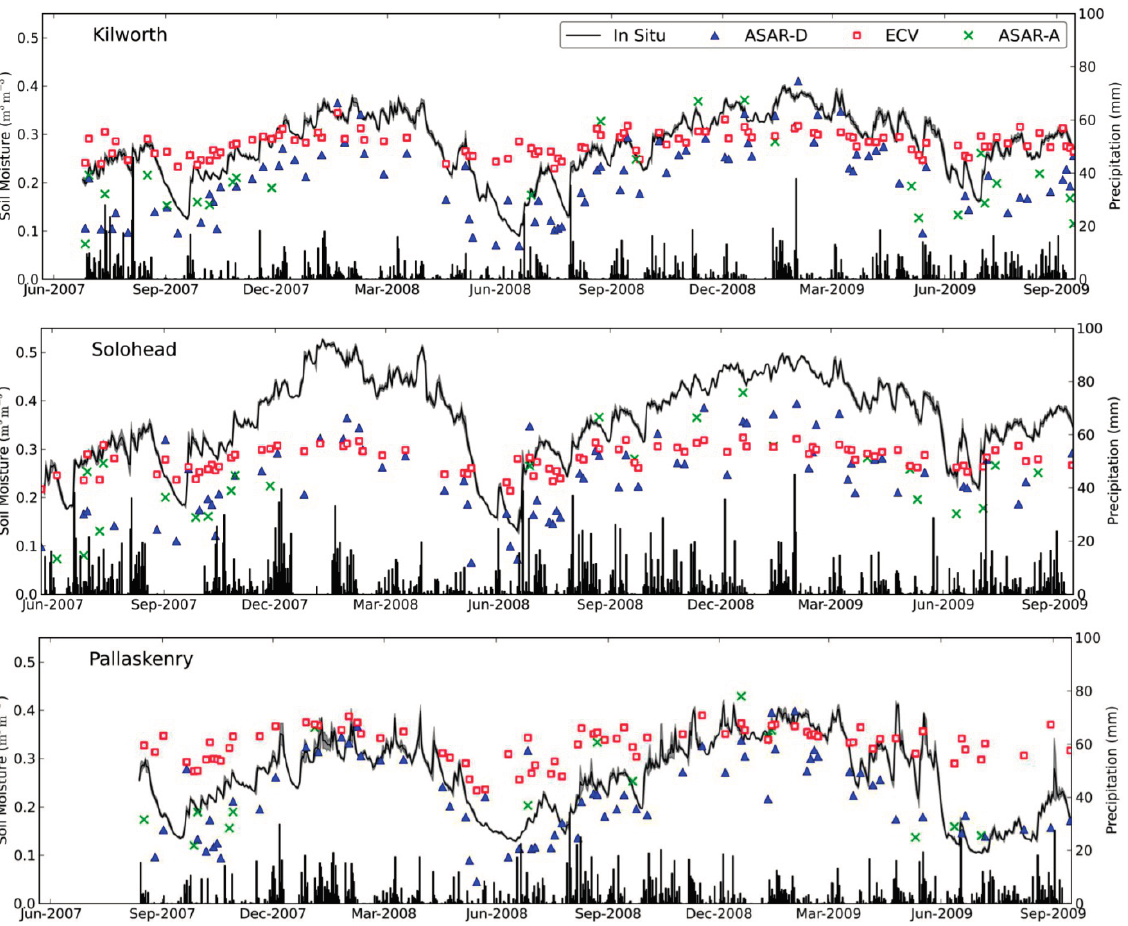
Figure 2. Temporal trend of the soil moisture in the sites under investigation. The in situ instruments provide measurements every 30-min. The soil moisture retrieved from ascending and descending ASAR acquisitions is compared with that provided by the ECV product. The total daily precipitation is also